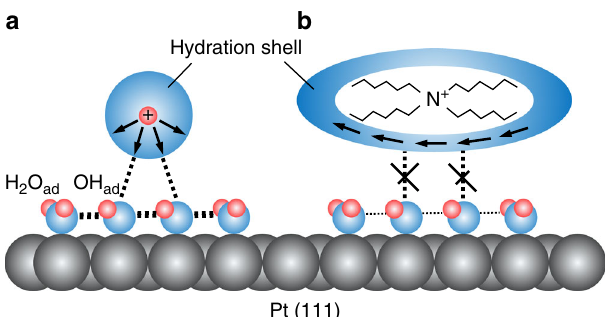
Fig. 5 Schematic of interfacial hydrated cations and adsorbed hydroxide species. a hydrophilic cation and ( b ) hydrophobic cation. Arrows indicate the direction of water dipole within the hydration shell. (Platinum is represented by gray spheres, oxygen by blue spheres, and hydrogen by pink